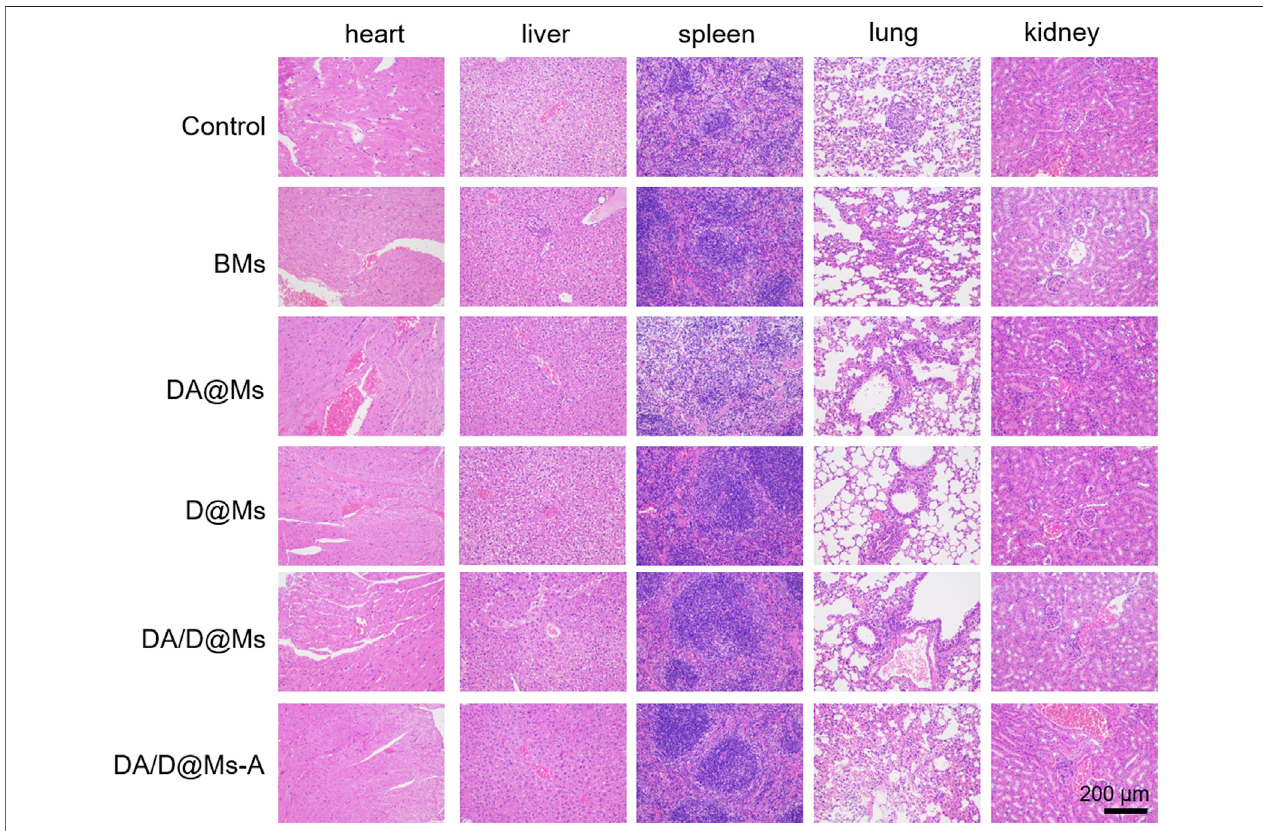
FIGURE 6 | HE stained major organs collected from mice post intraperitoneal administration of micelles every other day for 2 weeks. Scale bar = 200 μ m.